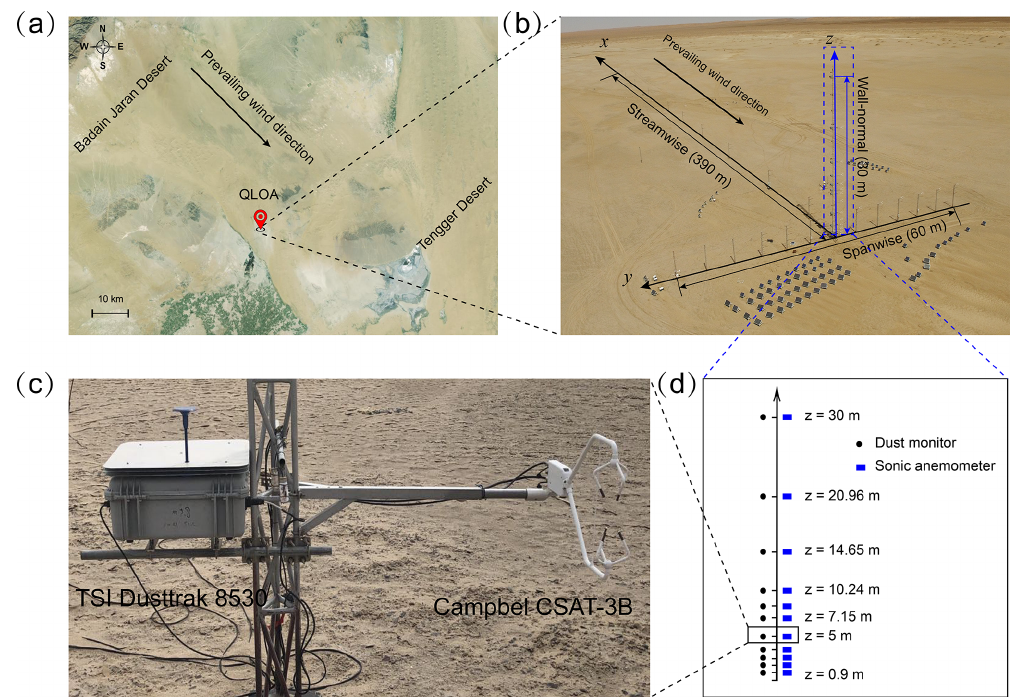
Figure 1. The field observational site and measurement array: (a) satellite photographs of the QLOA site (© Google Earth), (b) panoramic view of the QLOA, (c) the photos of experimental instruments (dust monitor and sonic anemometer), and (d) the southeast view of the sonic anemometers (square) and dust monitors (circle) array on the wall-normal